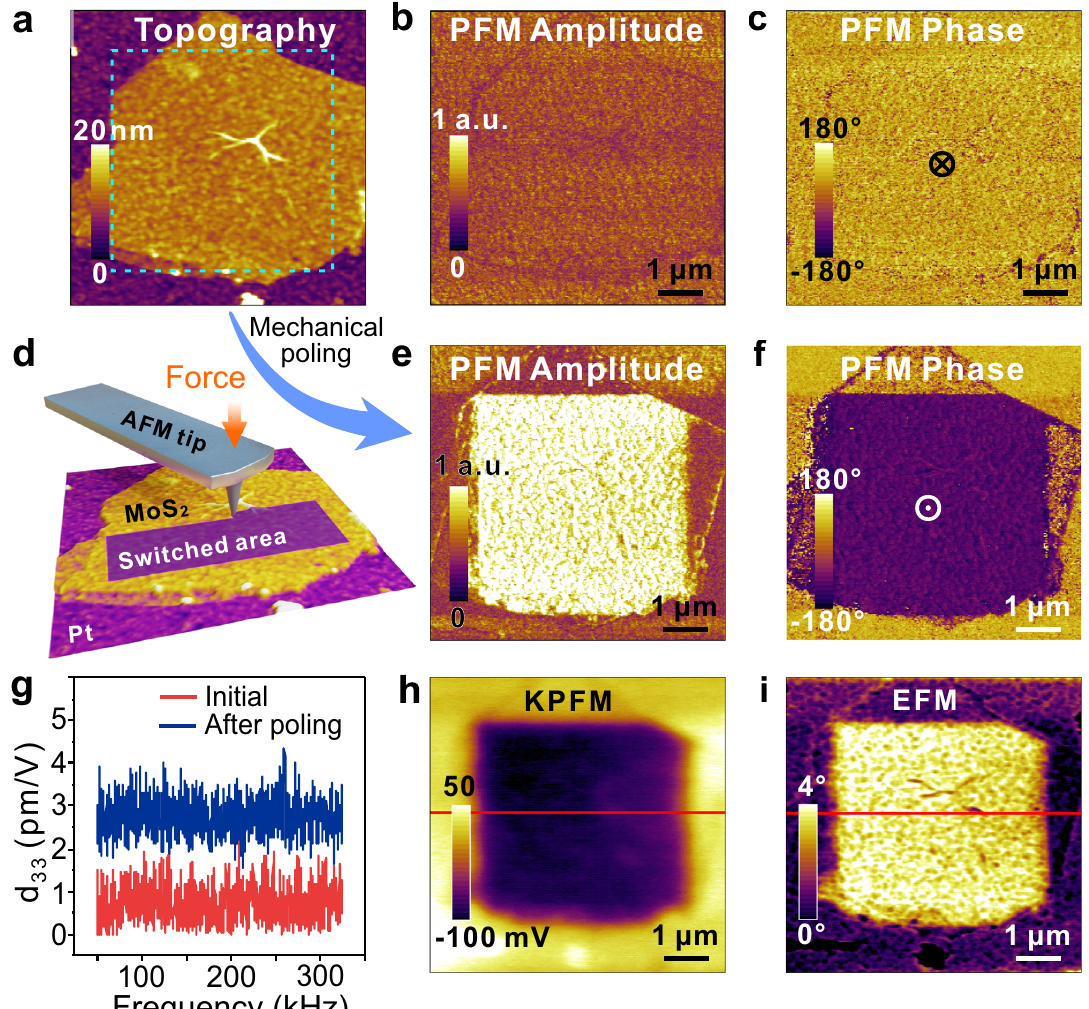
Fig. 3 Probing the electromechanical and electrical properties of 1T ” -MoS 2 . a Topographic image of the pristine 8-nm-thick fl ake. The dashed line represents the 5 × 5 µm 2 region that is subjected to a mechanical load of 1100 nN. b , c PFM amplitude ( b ) and phase ( c ) images of the pristine 1T ” -MoS 2 fl ake. d Schematics of an experiment on application of mechanical stress by a PFM tip. e , f PFM amplitude ( e ) and phase ( f ) images of the same 1T ” -MoS 2 fl ake after application of mechanical stress. g The frequency-dependent piezoelectric response acquired by LDV in the pristine and mechanically poled regions of the 1T ” -MoS 2 fl ake. h , i KPFM ( h ) and EFM ( i ) maps of the 1T ” -MoS 2 fl ake after application of mechanical stress. A bright region in the EFM phase image ( i ) acquired with a dc read bias of + 3 V corresponds to the negative surface charge, which is further corroborated by the reduced contact potential difference in the same region seen in the KPFM image ( h